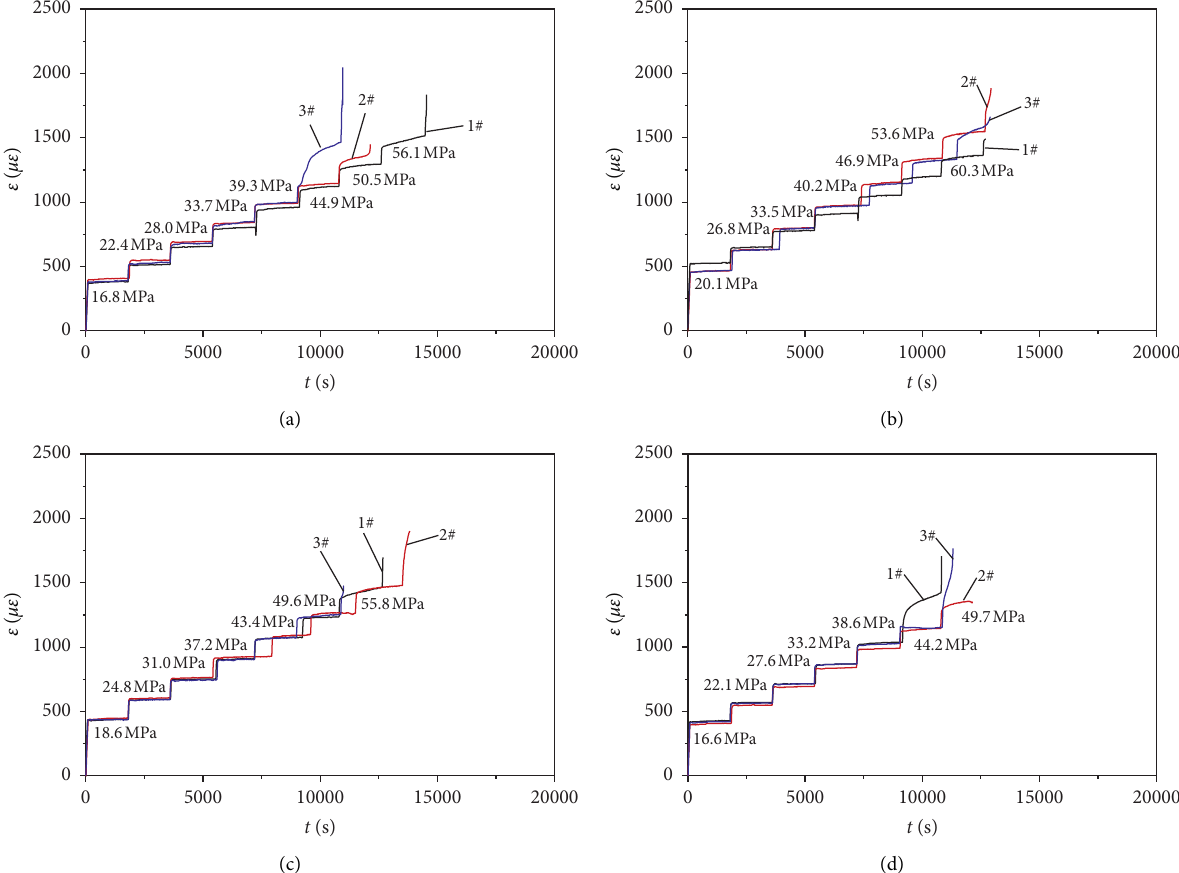
Figure 4: Creep-time ( ε cp - t ) curves of concrete mixed with fly ash replacement ratios of (a) 0, (b) 20, (c) 35, and (d) 50 wt% during gradation loading.